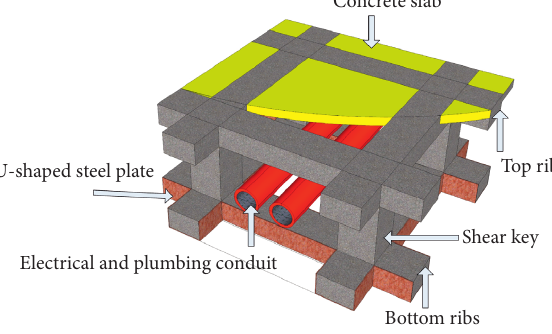
Figure 1: Components of the composite floor.